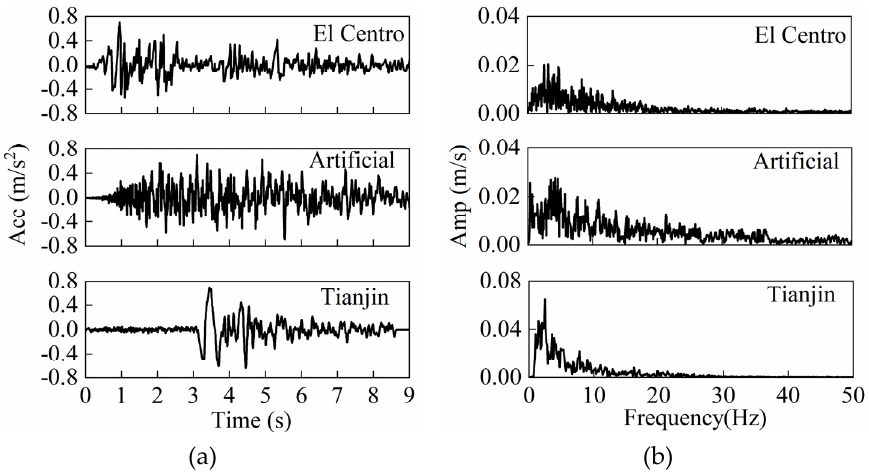
Figure 6. Acceleration time–history curves and Fourier spectra of the three seismic waves. ( a ) Acceleration time–history curves; ( b ) Fourier spectra.